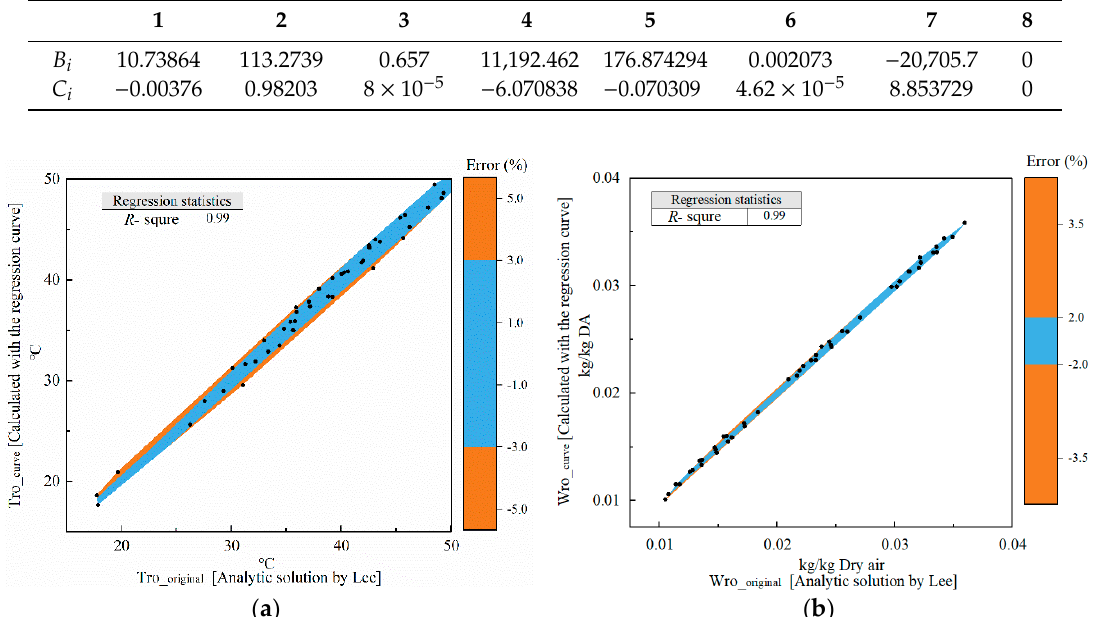
Figure 6. Accuracy validation of the coefficients obtained with the analytic solution by Lee [27]: ( a )